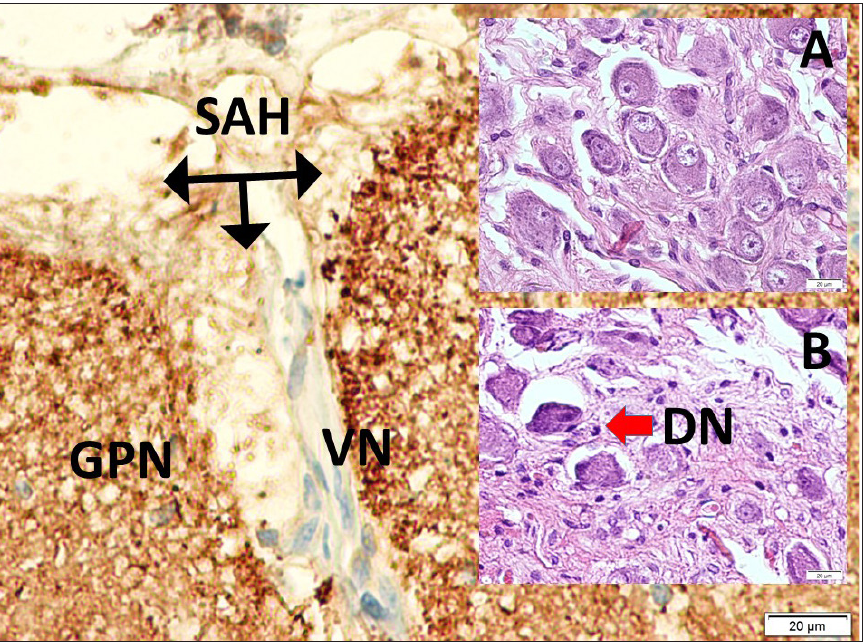
Figure 2. Histological view of the normal carotid body (LM, H&E, x40/A) and degenerated carotid body neurons (DN/LM, H&E, x40/B) and bloody and fibrotic bands developed subarachnoid space between glossopharyngeal and vagal nerve fibers entering the jugular foramen (LM, GFAP,